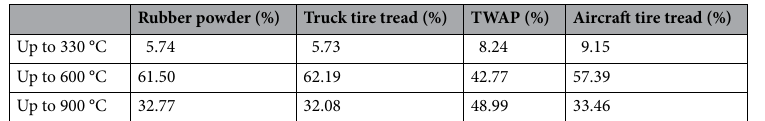
Table 2. Normalized mass changes of thermogravimetric